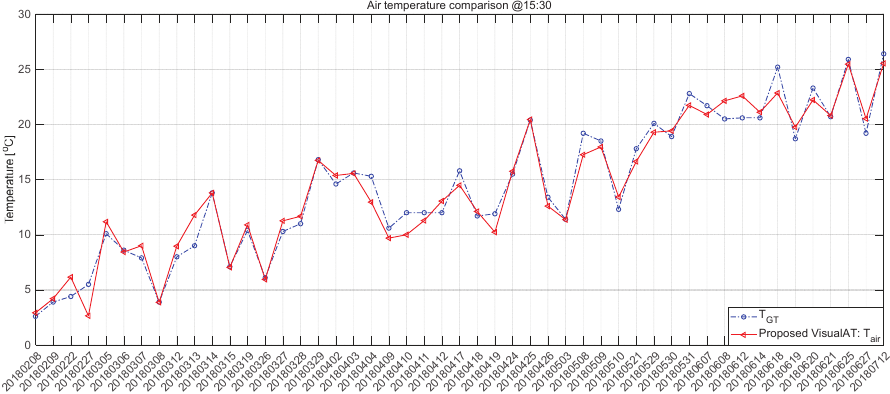
Figure 21. Quantitative evaluation graph of the proposed VisualAT method for the whole database acquired from February to July 2018.